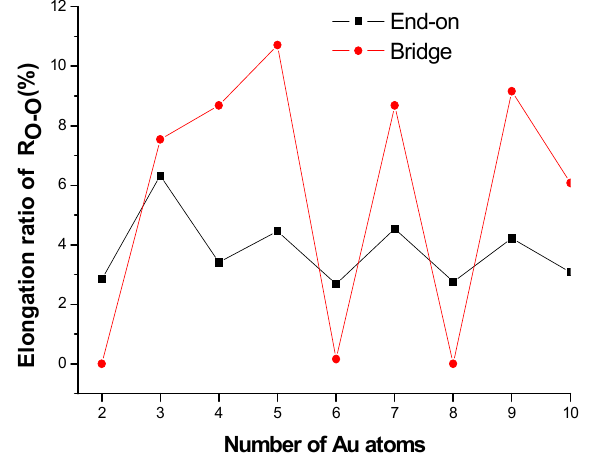
with cluster size. O–O